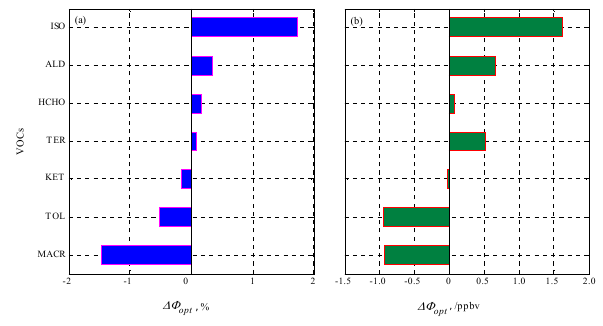
Fig. 6. Detailed comparison of the changes of Φ opt ( Δ Φ opt ) due to the increase of VOCs concentrations at 11:50JST of 18 September. TER: monoterpenes.